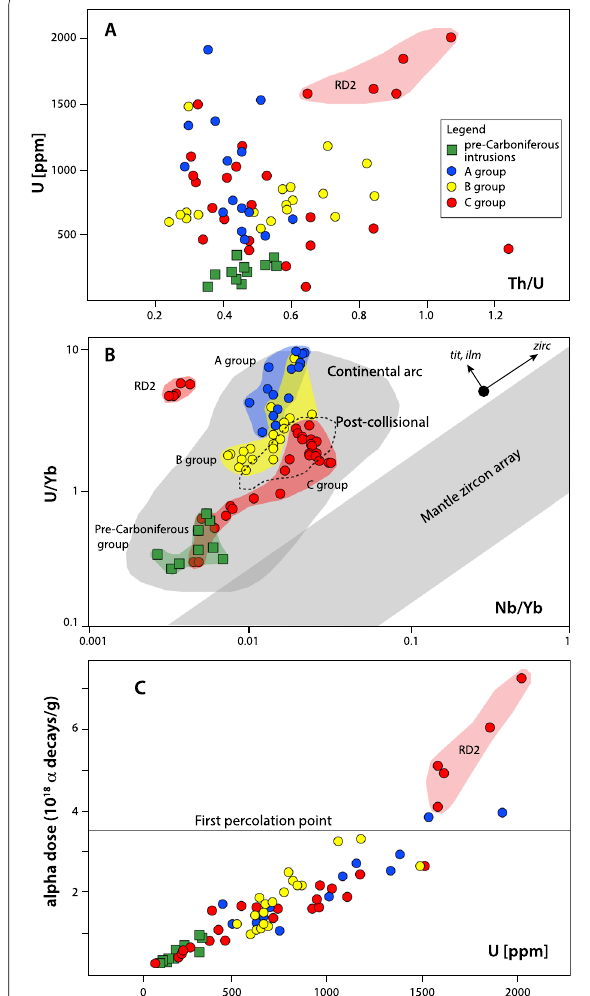
Fig. 6 Trace element data from zircon. A U vs. Th/U; B U/Yb vs. Nb/Y; the mineral vectors in B show the qualitative effect of fractionation of titanite, ilmenite and zircon on U/Yb and Nb/Yb ratios of the remaining melt and later crystallized zircon (after Grimes et al., 2015); C Alpha dose calculations compared to U concentration analyses of representative zircons from the LA-ICP-MS dated